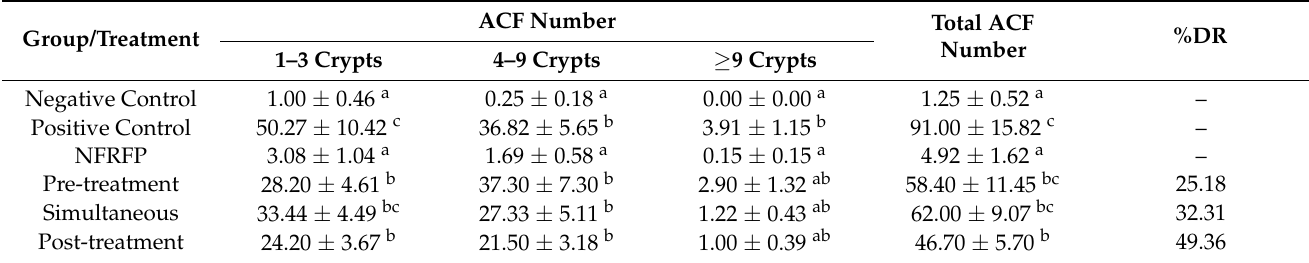
Table 2. Effect of consumption of Natural Fiber-Rich Food Product (NFRFP) on the frequency of aberrant crypts foci and reduction of damage to the colon of rats treated with 1,2-dimethylhydrazine (DMH).